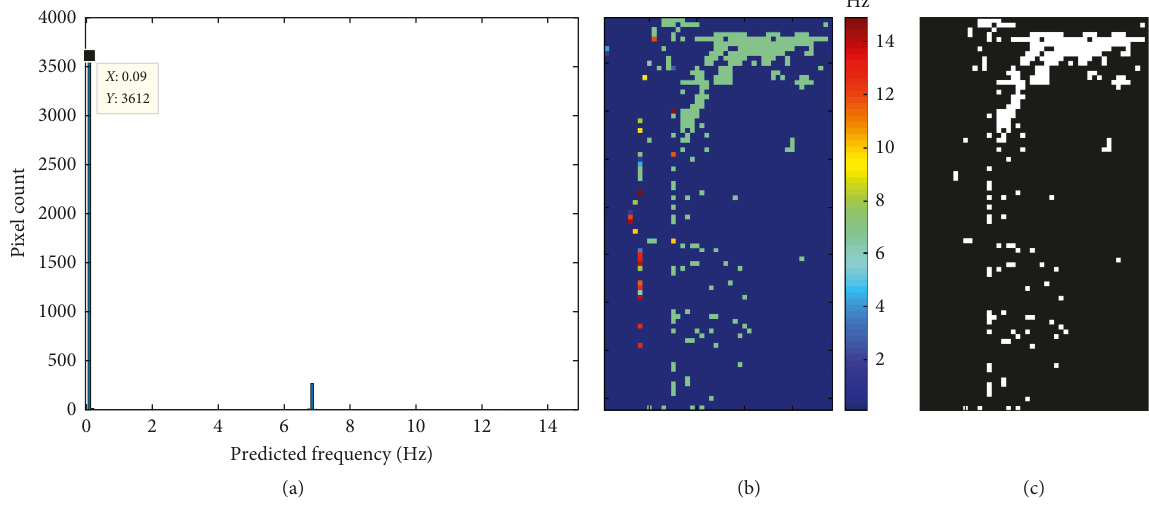
Figure 26: Simply supported carbon plate experimental case 1 result from FFT peak picking. (a) Histogram of peak picking result distribution. (b) Result visualization in their original spatial position. (c) Highlighted pixels predicted as 6.8 Hz for